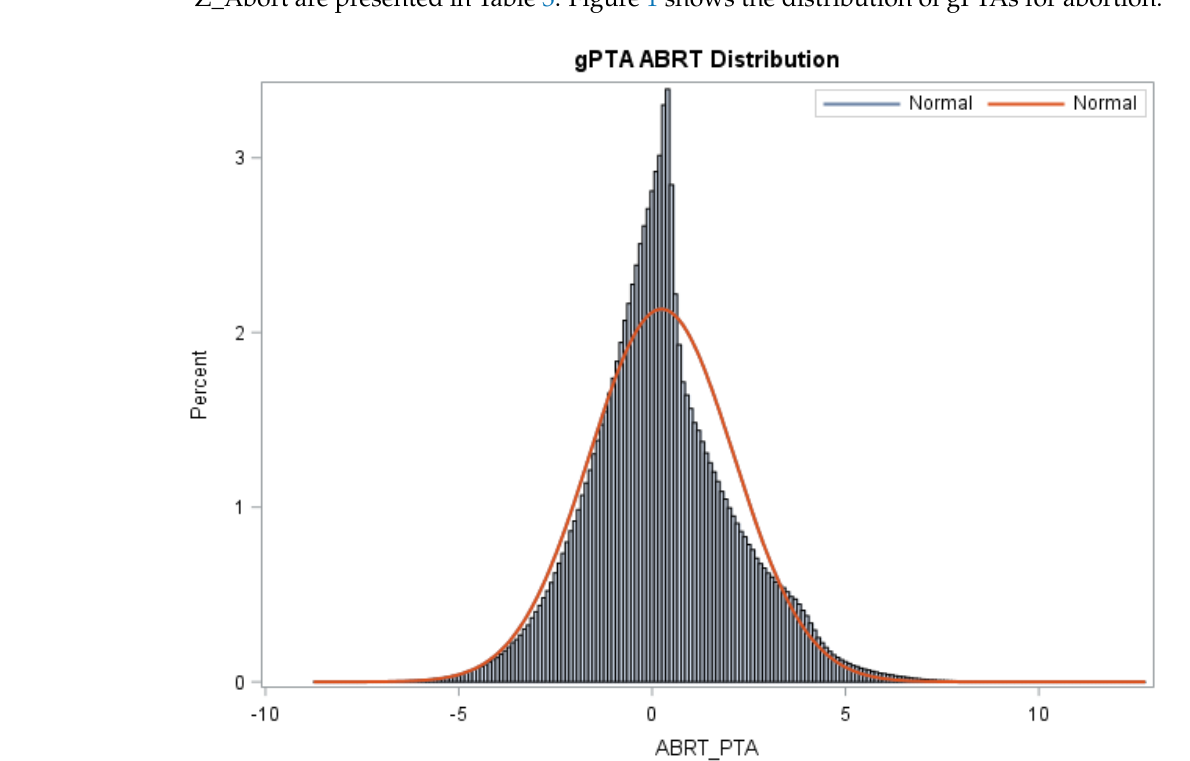
Figure 1. Distribution of gPTAs (Z_Abort PTA) for abortion for all animals in the Holstein evaluation. An appreciable variation in gPTAs is observed in the Holstein population sampled in the present study.